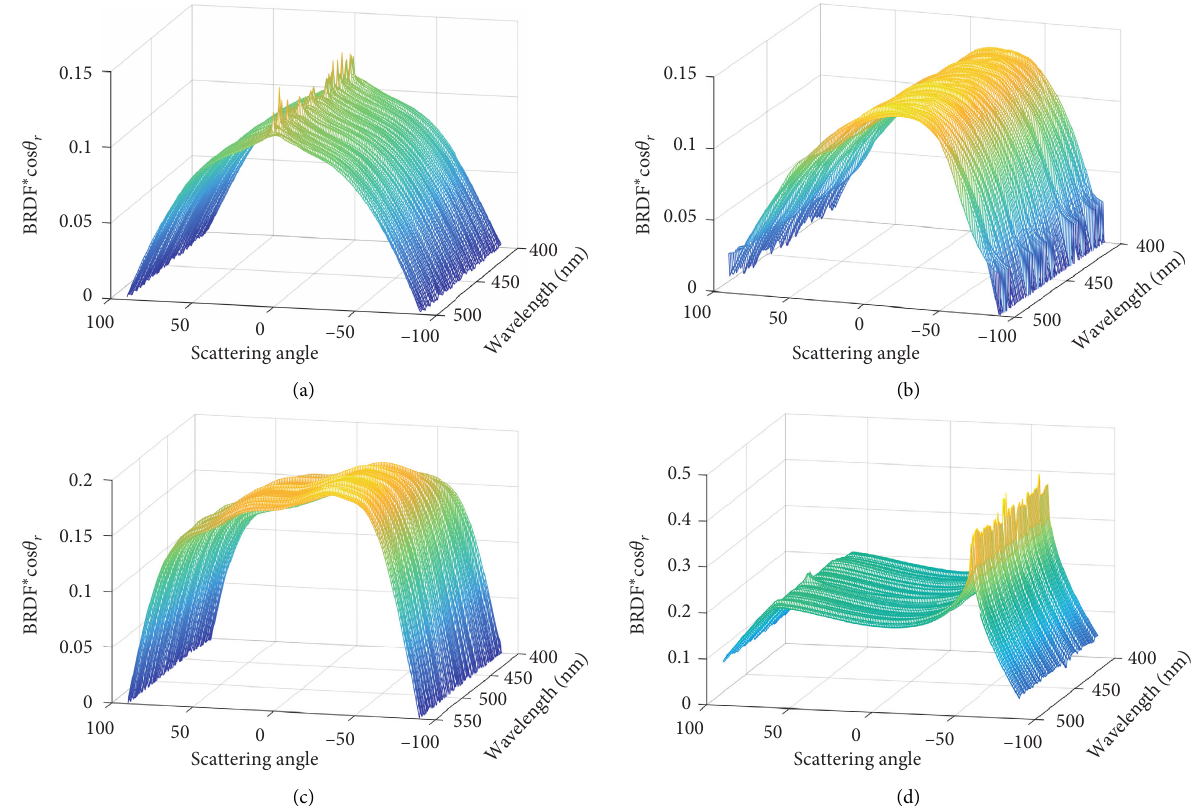
Figure 12: Fitted 3D graph of sample 4. (a) Fitted 3D graph of the 0 ° incident angle; (b) fitted 3D graph of the 30 ° incident angle; (c) fitted 3D graph of the 45 ° incident angle; (d) fitted 3D graph of the 60 ° incident angle.